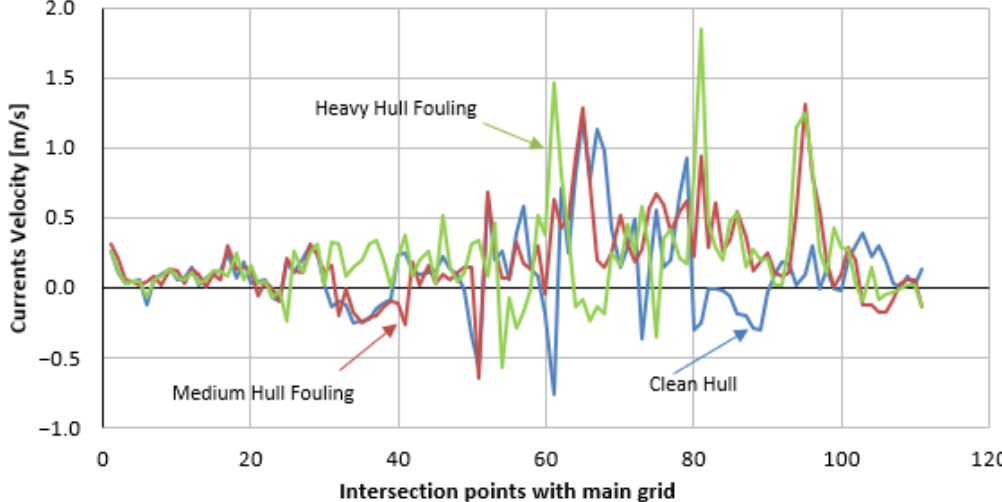
Figure 8. Currents’ velocity along the optimal paths for different hull fouling conditions.